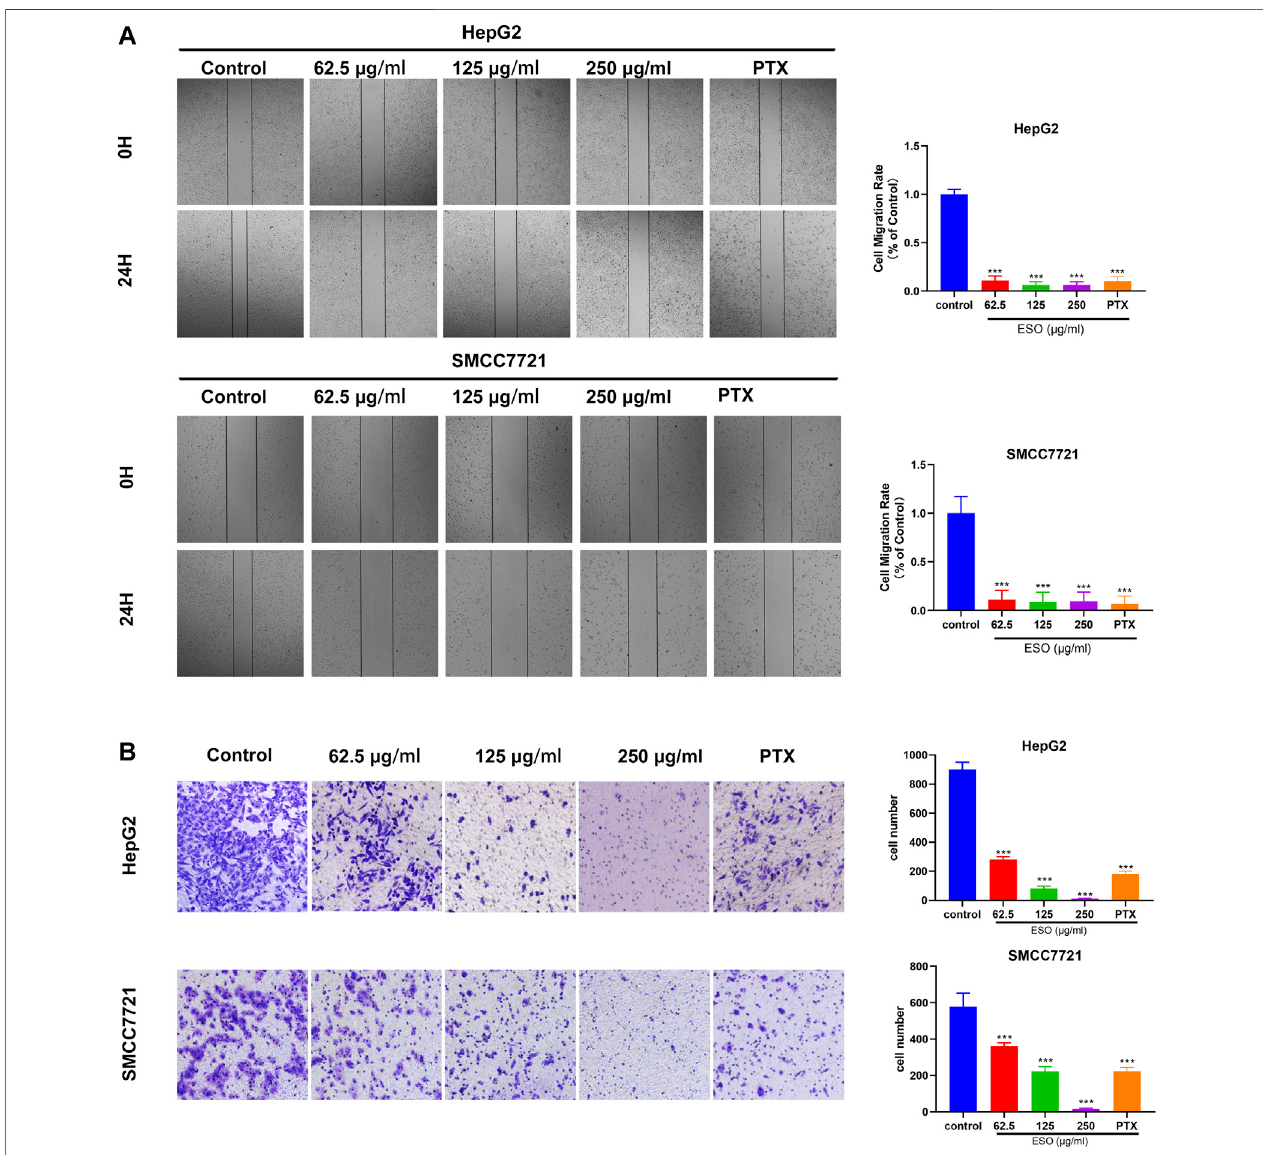
FIGURE 8 | SO inhibits human HCC cell migration and invasion (A) Wound healing migration assay of HepG2 and SMCC7721 cells in the presence of ESO. n (cid:2) 3. (B) Transwell invasion assay Hepg2 and SMCC7721 cells in the presence of ESO. n (cid:2) 3. The concentration of PTX of positive control group was 40 nM, * p < 0.05, ** p < 0.01, *** p < 0.001 vs. the nontreated control group.